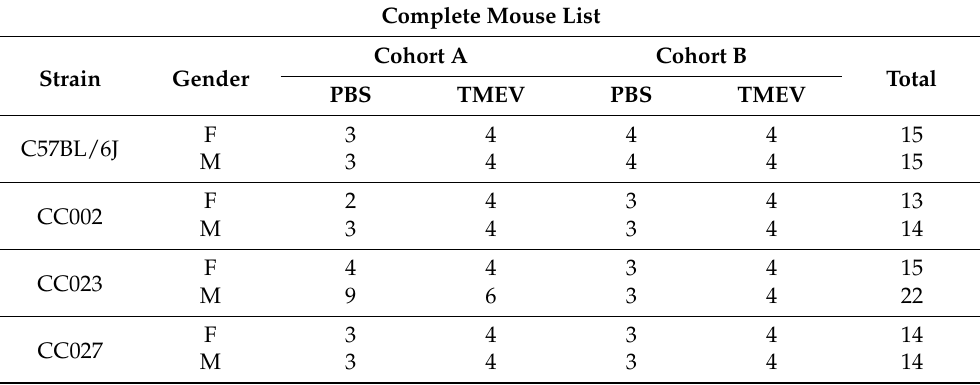
Table 1. Mice were allocated to treatment groups after weaning at three to four weeks of age.